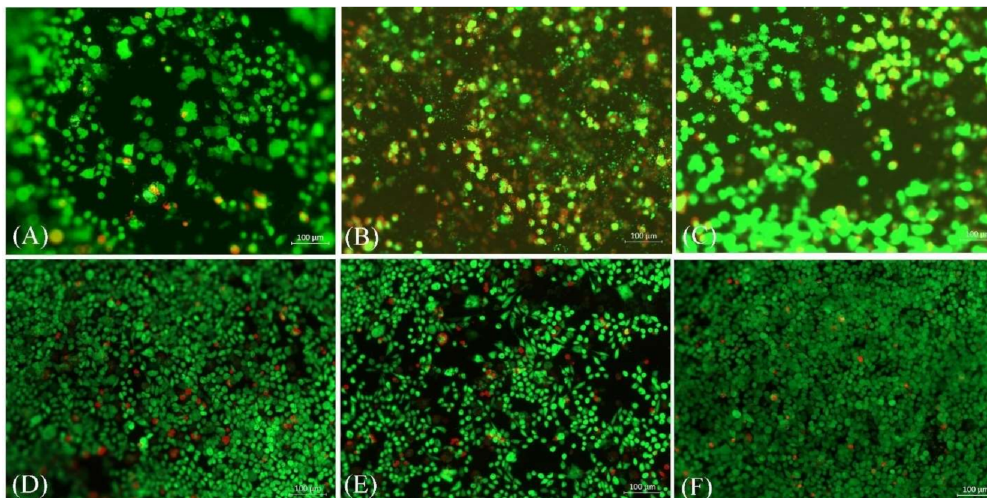
Figure 5. Live/dead staining images of the fibroblast cells grown on the prepared samples (CNF, CNF/8HA, and CNF/8HA (hydrothermally)after three days incubation( A – C )and after seven days of incubation ( D – F ), respectively. Live cells are shown in green and dead cells are red.